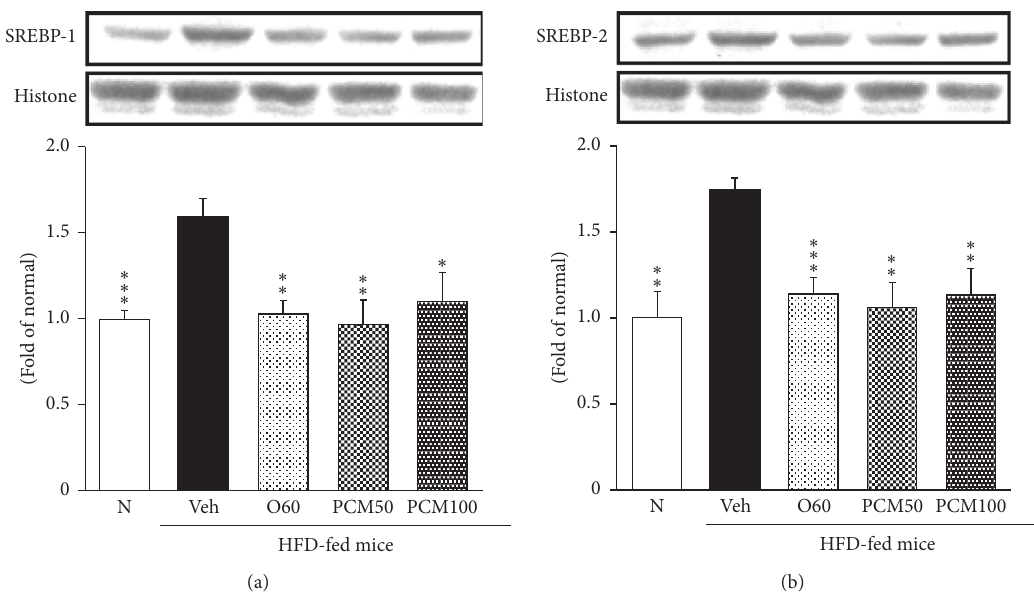
Figure 5: SREBP-1 (a) and SREBP-2 (b) protein expressions in the liver. N, normal mice; Veh, HFD control mice; O60, orlistat 60mg/kg- treated and obese mice; PCM50, PCM 50mg/kg-treated and obese mice; PCM100, PCM 100mg/kg-treated and obese mice. Data are the mean ± SEM, n � 7. Significance: ∗ p < 0.05, ∗∗ p < 0.01, and ∗∗∗ p < 0.001 versus HFD control mice. SREBP-1, sterol regulatory element binding protein-1; SREBP-2, sterol regulatory element binding